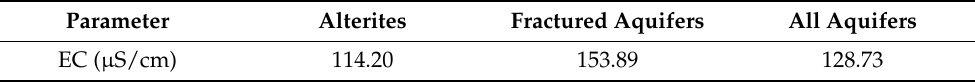
Table 2. Average values of electrical conductivity according to aquifer type. Parameter